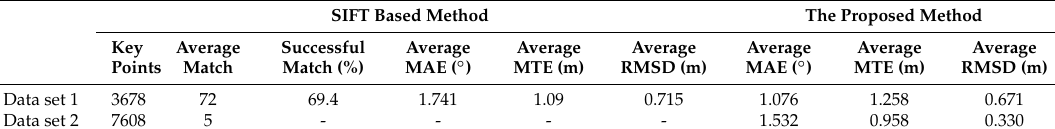
Table 7. Comparison between the proposed method and SIFT-based method.